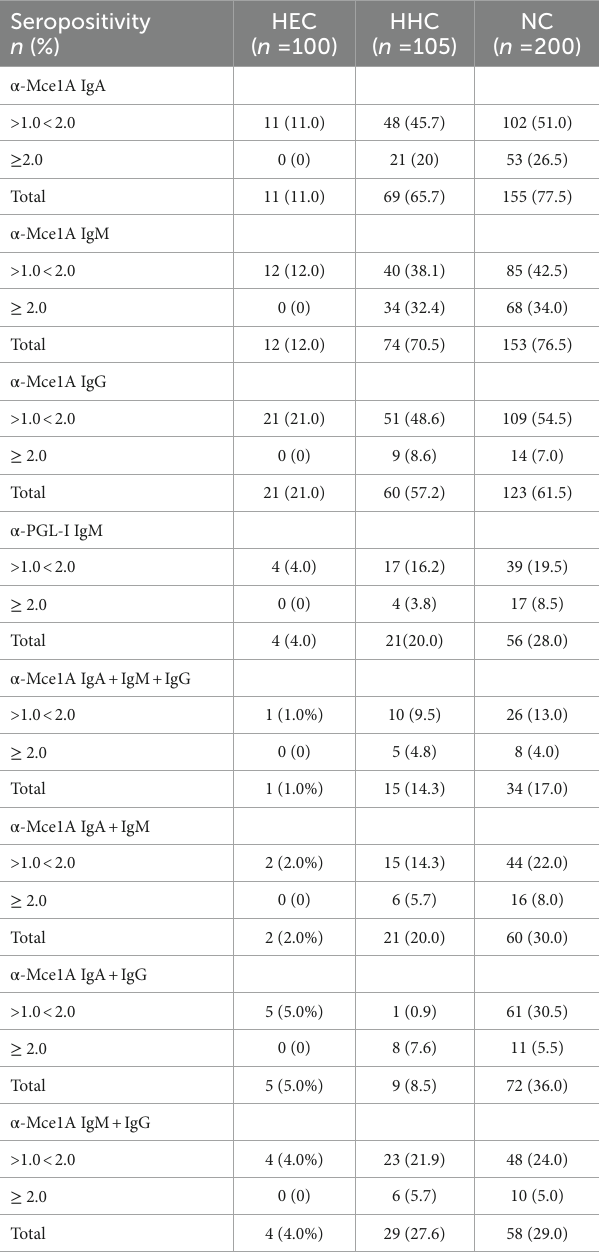
TABLE 3 Positivity profile of serological biomarkers in HD diagnosis. Seropositivity n